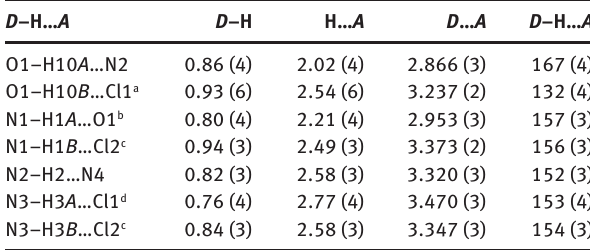
Table 1: Hydrogen-bond geometry (Å, °